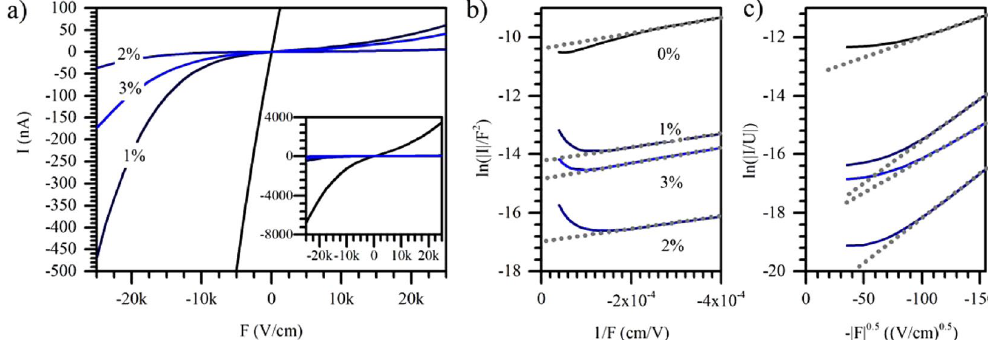
Figure 5. IV-characteristics of PtIr/ZnO/ITO layer diode; ( a ) linear plots; inset: linear plot for all 4 samples on larger scale on the current axis; ( b ) Fowler-Nordheim plot; ( c ) Poole-Frenkel plot. In order to directly keep related to the investigated solar cell devices ( b and c ) show the negative field only where the electrons move from the ZnO-NWs to the